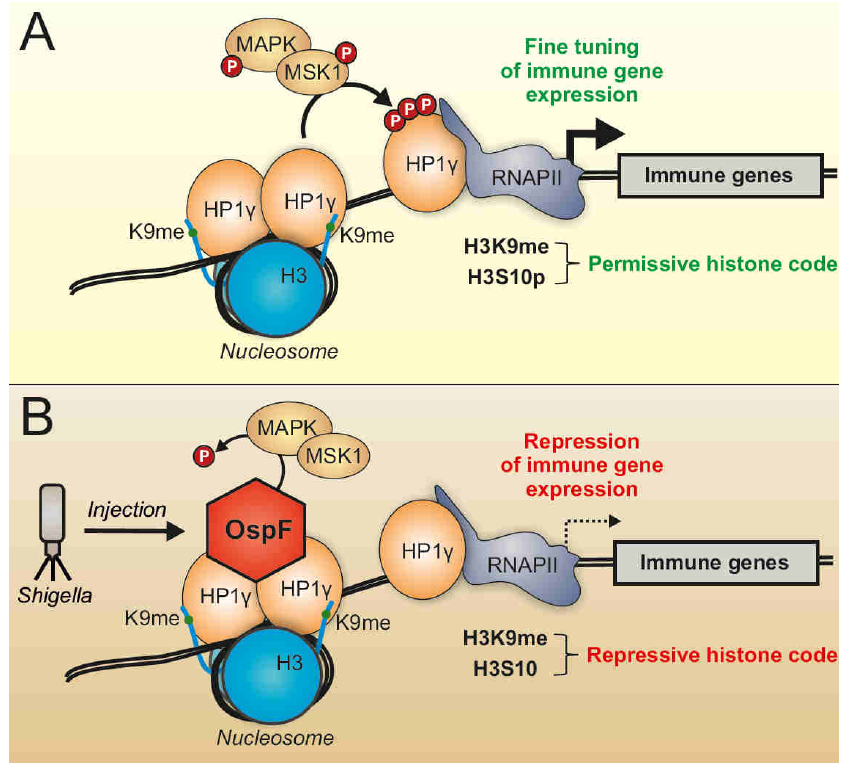
FIGURE 1: The T3SS